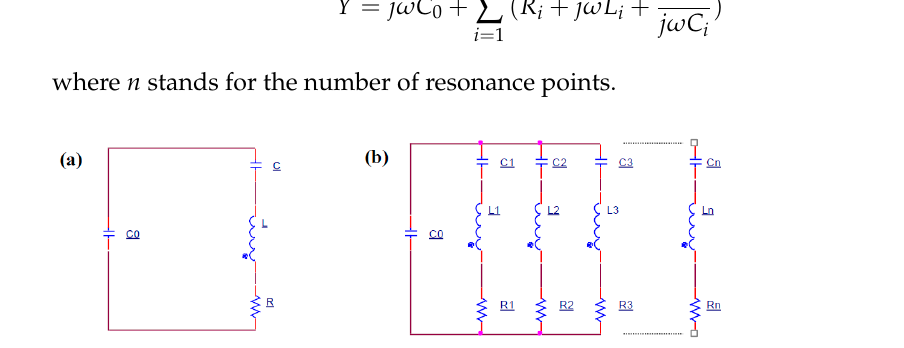
Figure 9. Equivalent circuit of piezoelectric transducer: ( a ) single mode equivalent circuit, ( b ) multimode equivalent circuit model.